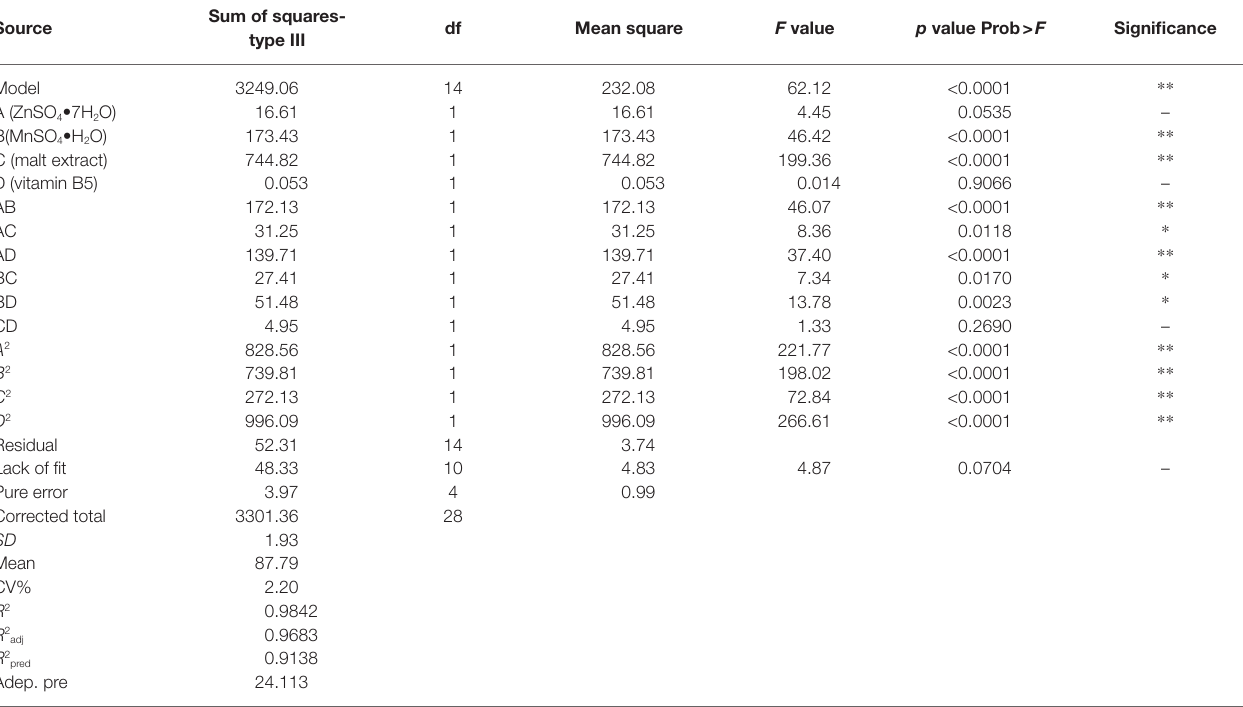
TABLE 3 | ANOVA for the effect of ZnSO 4 •7H 2 O, MnSO 4 •H 2 O, vitamin B5, and malt extract on yellow monascus pigment production and regression coefficients. Sum of squares- Source type